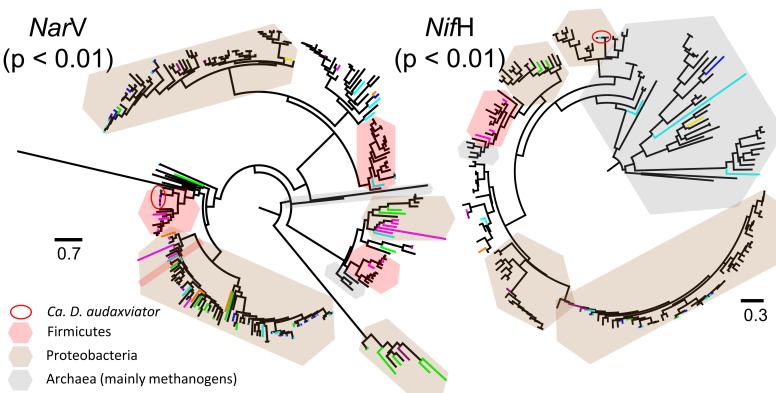
Maximum likelihood trees of deduced amino acid sequences of NarV and NifH genes detected in assembled metagenomes. Sequences from this study are highlighted by color lines, with blue for BE2011, cyan for BE2012, orange for DR5, green for FI88, magenta for TT107, dark purple for TT109, and yellow for MM5. P-test significance values of unweighted UniFrac distances among metagenomes are given. Scale bars represent the amino acid substitution rate per site. Number of taxa and characters, and amino acid evolutionary models used are as follow: NarV gene: 273, 188, LG+G; NPD gene: 584, 248, LG+G; PAPS reductase gene: 479, 159, LG+G; NifH gene: 191, 268, LG+I+G; NifD gene: 154, 415, LG+I+G; NifK gene: 196, 419, LG+I+G; NifE gene: 137, 427, LG+I+G; and NifN gene: 84, 423, LG+I+G.